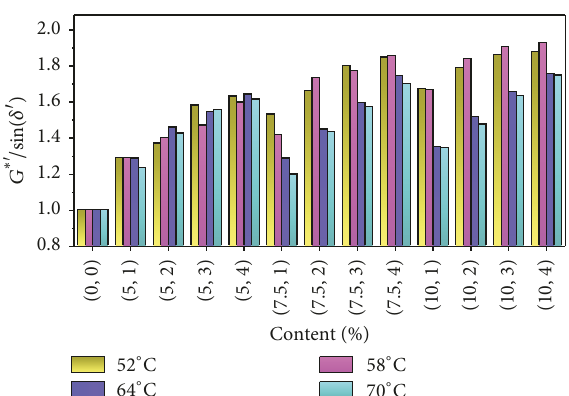
Figure 5: 𝐺 ∗󸀠 / sin 𝛿 󸀠 change trend graph.